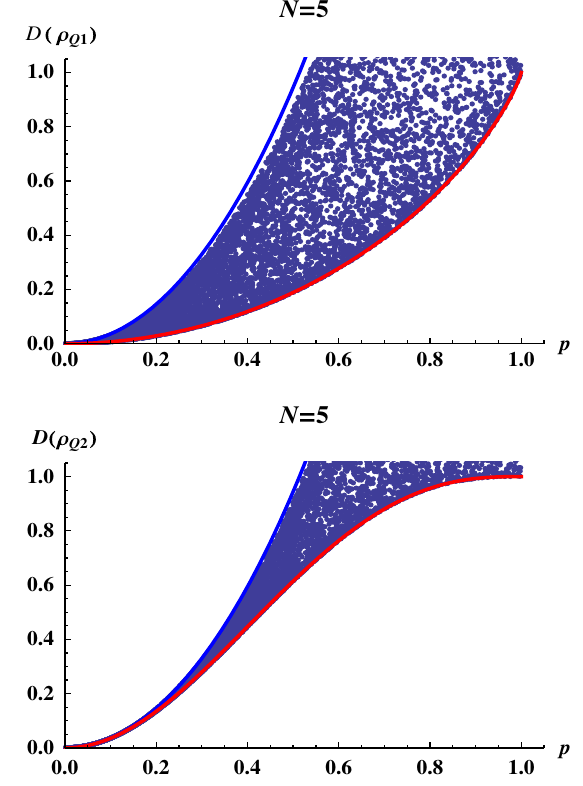
FIG. 3. Numerical simulation of discord for Q 1 ð Q 2 Þ . Simulation of quantum discord ( D ) for N ¼ 5 with 10 000 to obtain (cid:6) Q . The top random measurements on (cid:1) Q 1 ð Q 2 Þ 1 ð Q 2 Þ (blue) line is the maximum possible values for D , i.e., 5 (cid:1) D ¼ S ½ % Q 1 ð Q 2 Þ (cid:7) . The bottom (red) line is the conjectured S ½ (cid:6) S ½ % Q 1 ð Q 2 Þ (cid:7) (cid:1) Q 1 ð Q 2 Þ (cid:7) . All random measurement points fall between the two lines, suggesting that the conjectured formulas are correct given Table